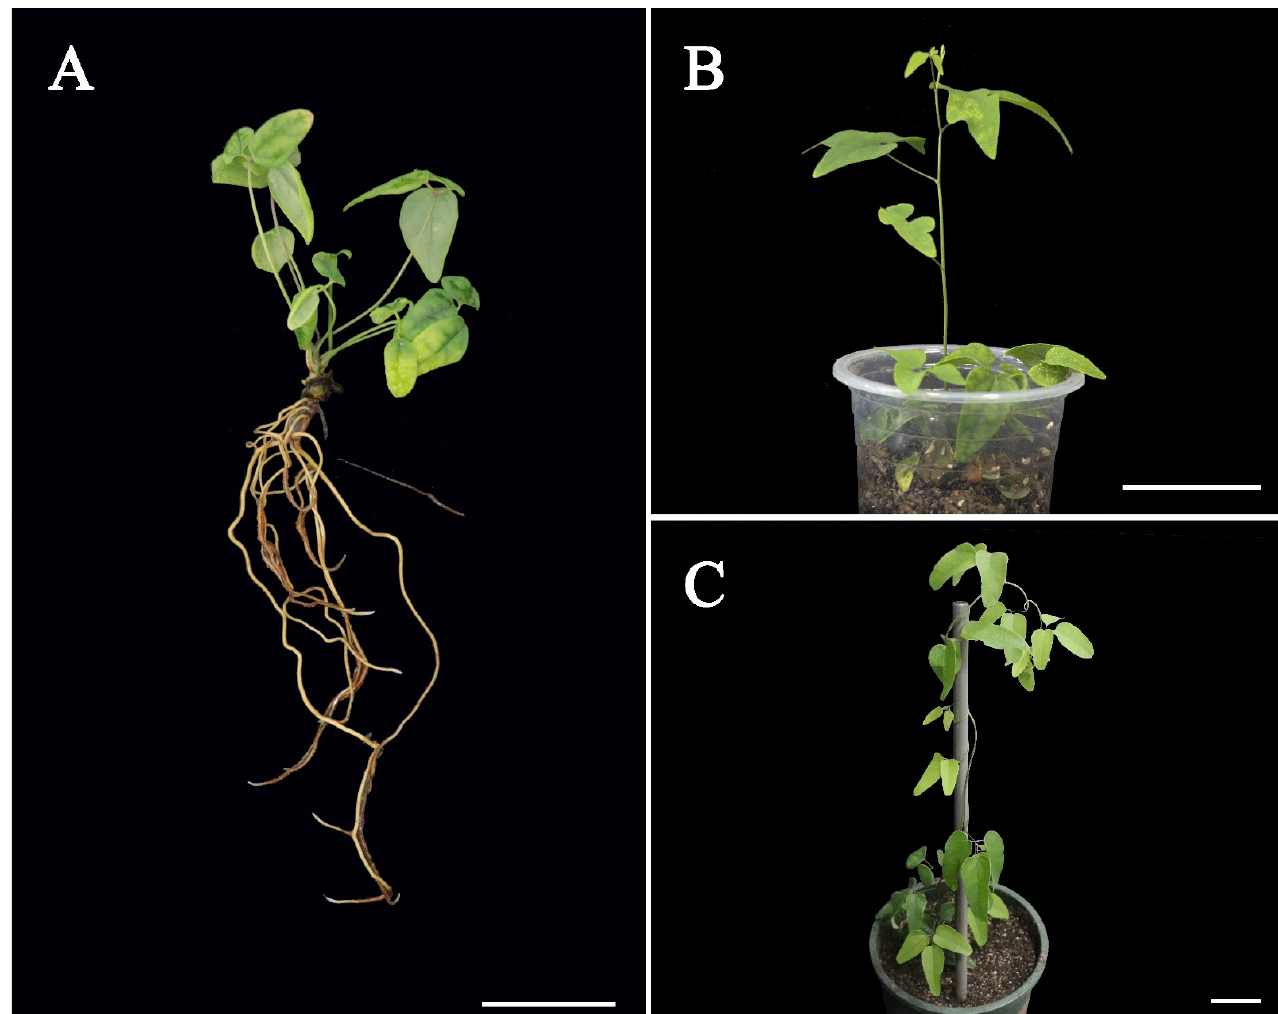
Figure 3. Plant acclimatization ex vitro and growth in plastic pots. ( A ) In vitro-regenerated plants with well-developed roots. ( B ) Surviving plants with new leaves after one month of acclimatization. ( C ) Vigorously growing plants after 2 months of culture in the plastic pots. Bars = 5 cm. Table 3. Descriptive statistics for the leaf morphological characteristics of the plants regenerated in vitro from immature seeds of wild A. trifoliate after 5 months of growth in plastic pots.